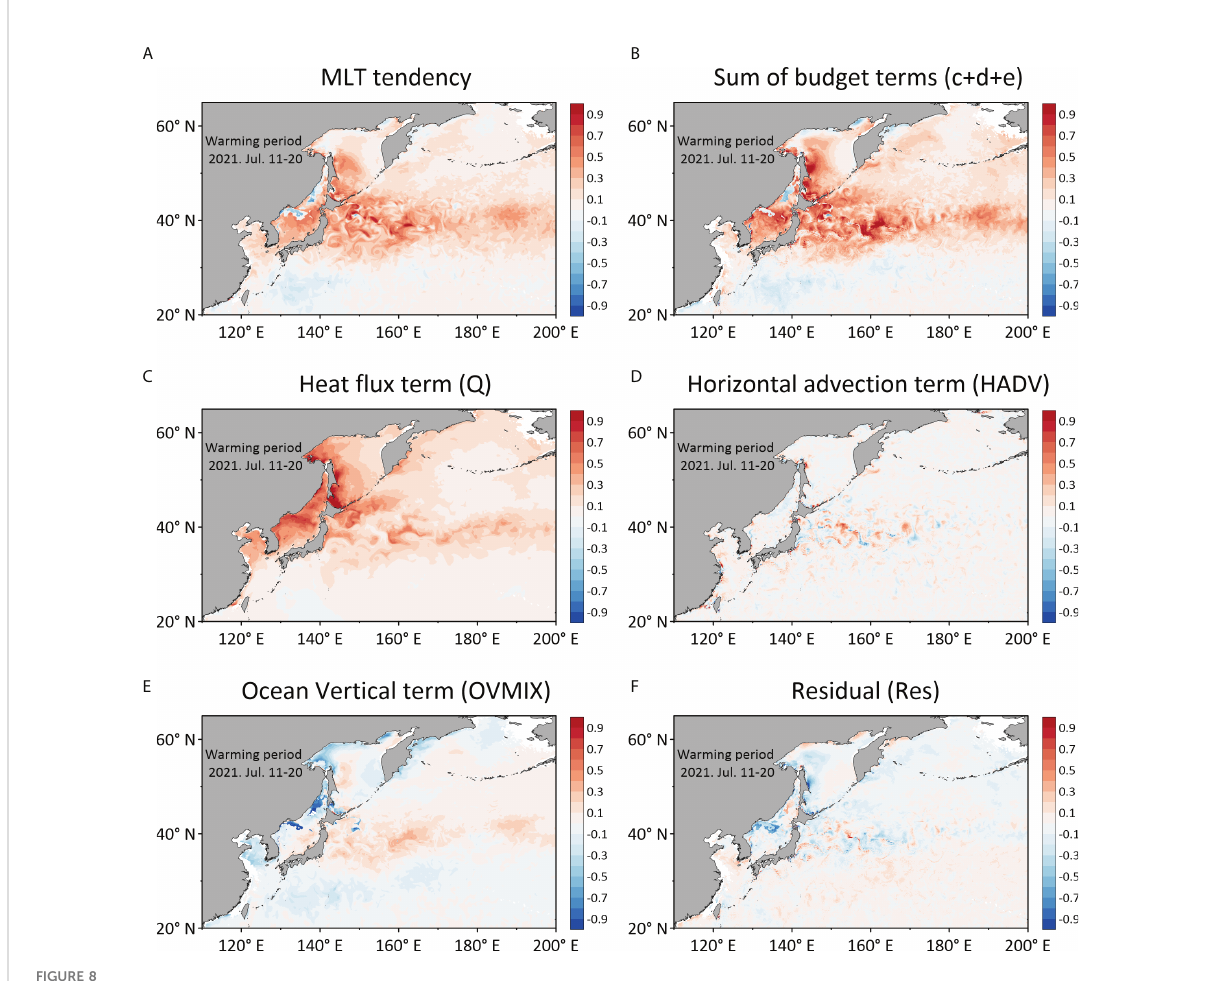
FIGURE 8 Spatial maps depicting the distribution of mixed-layer temperature (MLT) tendency budgets during the warming period: (A) MLT tendency, (B) sum of budget terms, (C) surface heat fl ux term (Q), (D) horizontal advection term (HADV), (E) ocean vertical mixing term (OVMIX), and (F) residuals